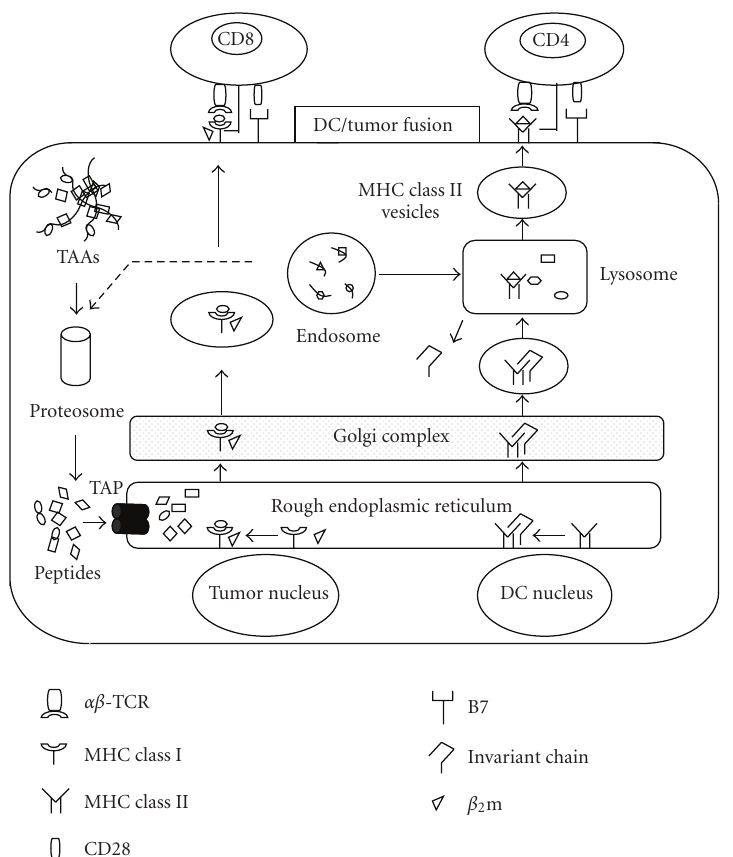
Figure 1: Antigen-processing and -presentation by DCs/tumor fusions. DCs/tumor fusions express MHC class I and II, costimulatory molecules (CD80 and CD86), and multiple tumor-associated antigens. The DCs/tumor fusions are able to process multiple tumor-derived peptides and MHC class I peptides derived from tumor and DCs. They form MHC class I-peptide complexes, in the endoplasmic reticulum, which are transported to the cell surface of fusions and presented to CD8+ T cells. The DCs/tumor fusions can also synthesize MHC class II peptides derived from DCs in the endoplasmic reticulum, which are transported to the cytoplasm, where MHC class II-peptide complexes are assembled with multiple tumor-derived peptides. These complexes are presented to CD4+ T cells, which are essential for induction of antigen-specific polyclonal